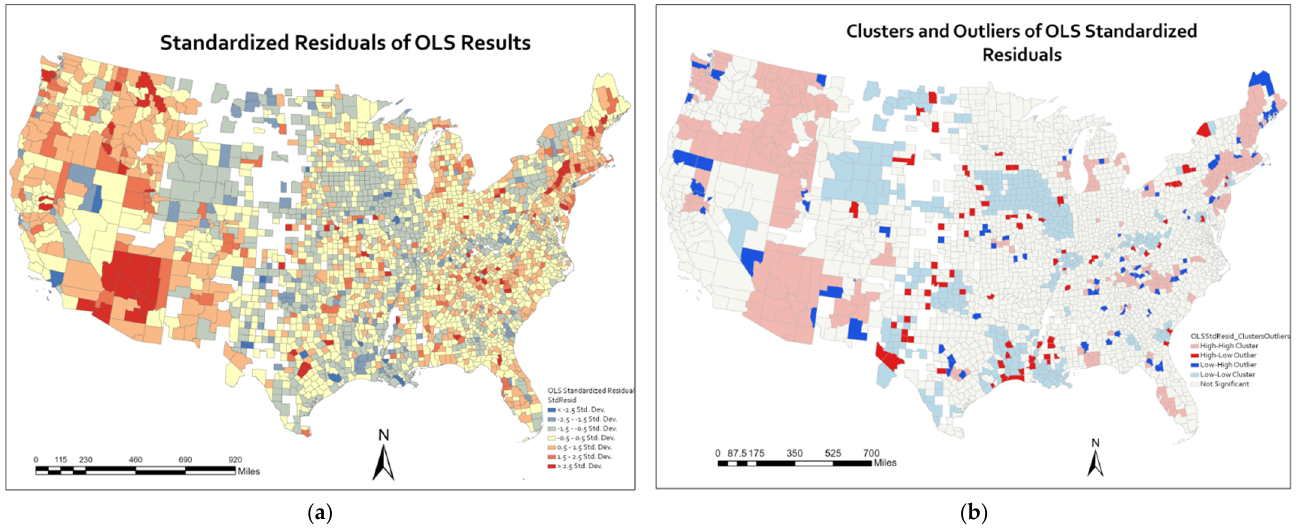
Figure 6. Spatial autocorrelation assessment results of the ordinary least squares (OLS) residuals. ( a ) Standardized residuals of the OLS results; ( b ) clusters and outliers of the OLS standardized residuals.